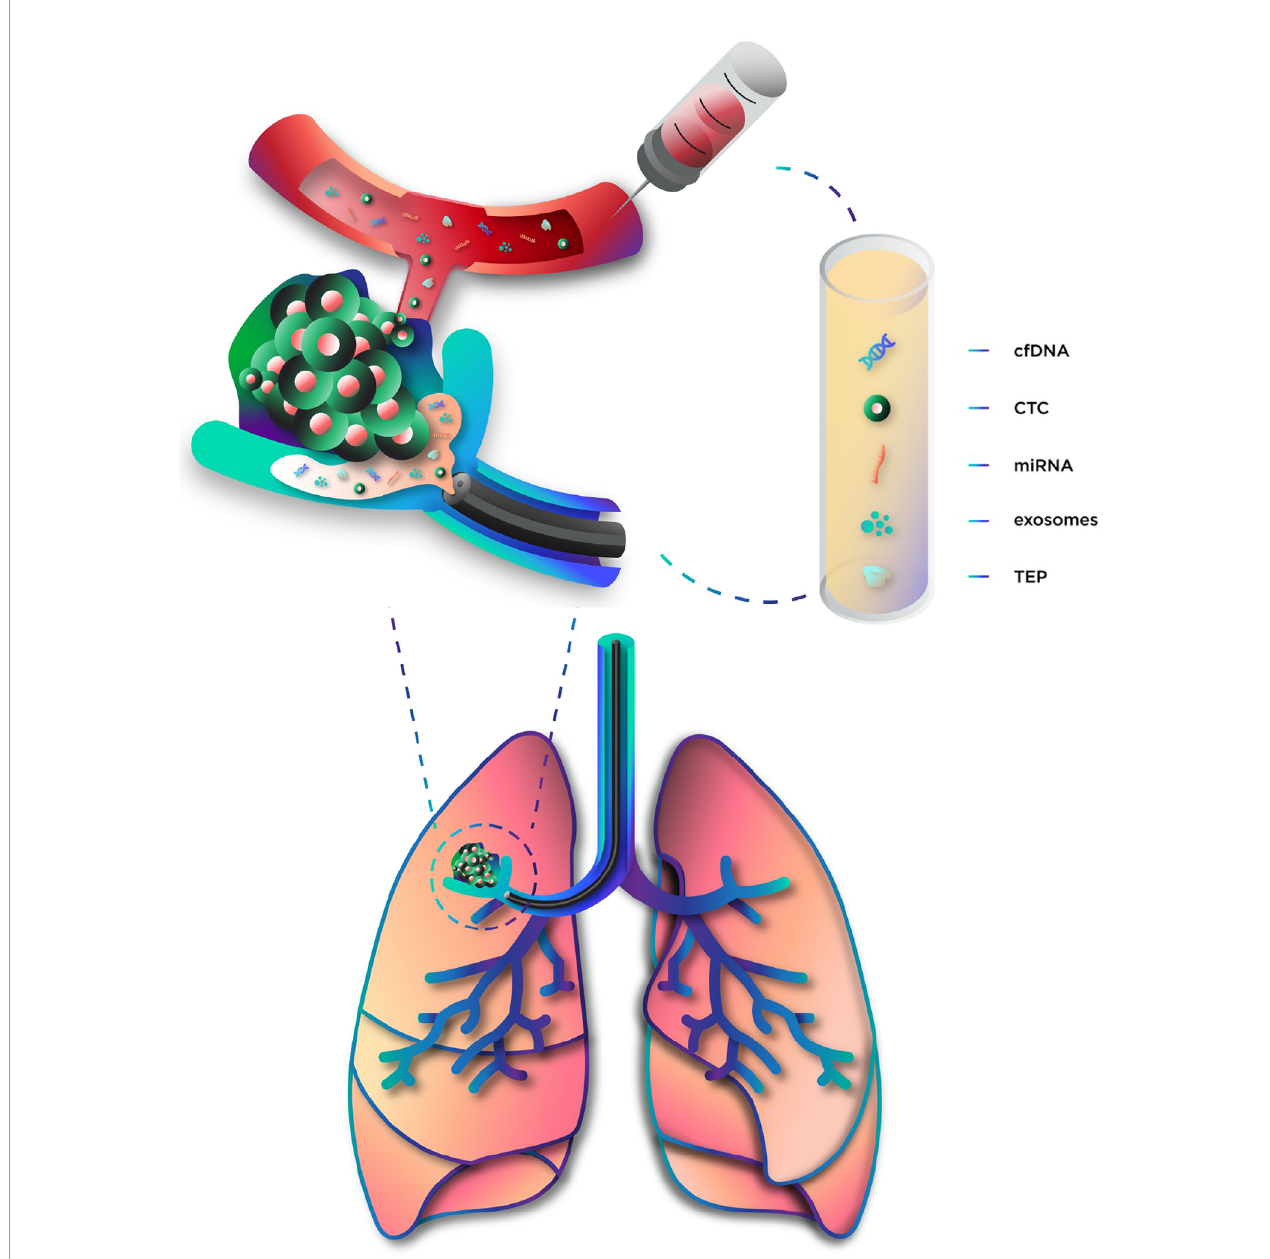
FIGURE 1 | Components of liquid biopsy. cfDNA, circulating cell-free DNA; CTC, circulating tumor cells; miRNA, microRNA; TEP, tumor-educated